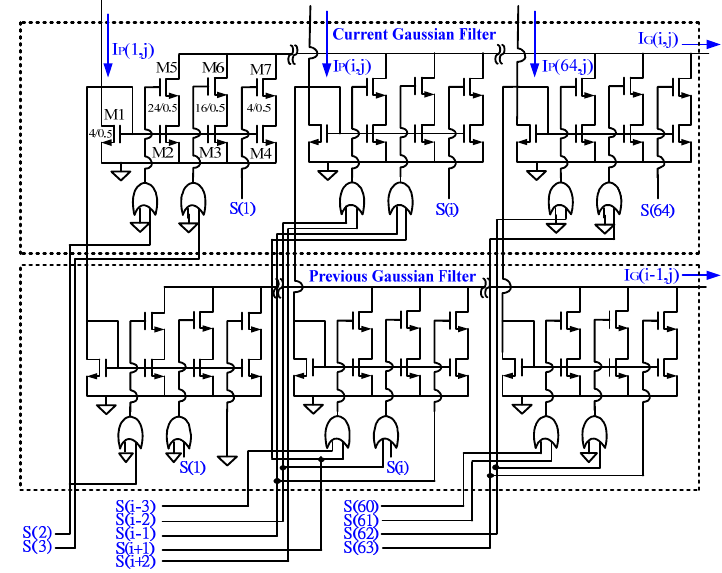
Figure 8. Proposed analogue circuit of the dual 1-D Gaussian filters. The channel width ratio of transistors M4, M3, and M2 (or M7, M6, and M5) is 1:4:6, from right to